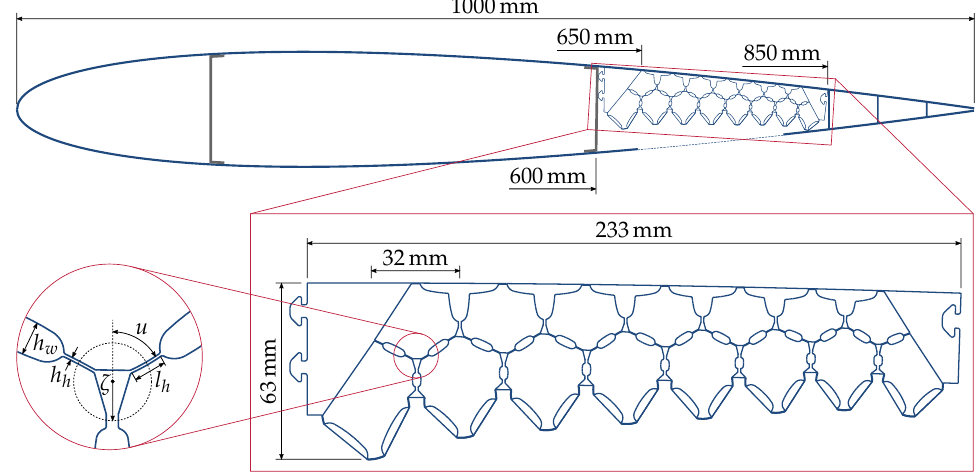
Figure 2. NACA0012 airfoil with integrated PACS. The actuated surface extents from 65% to 85% chord. The detail views show the PACS dimensions and the design parameters of the flexure